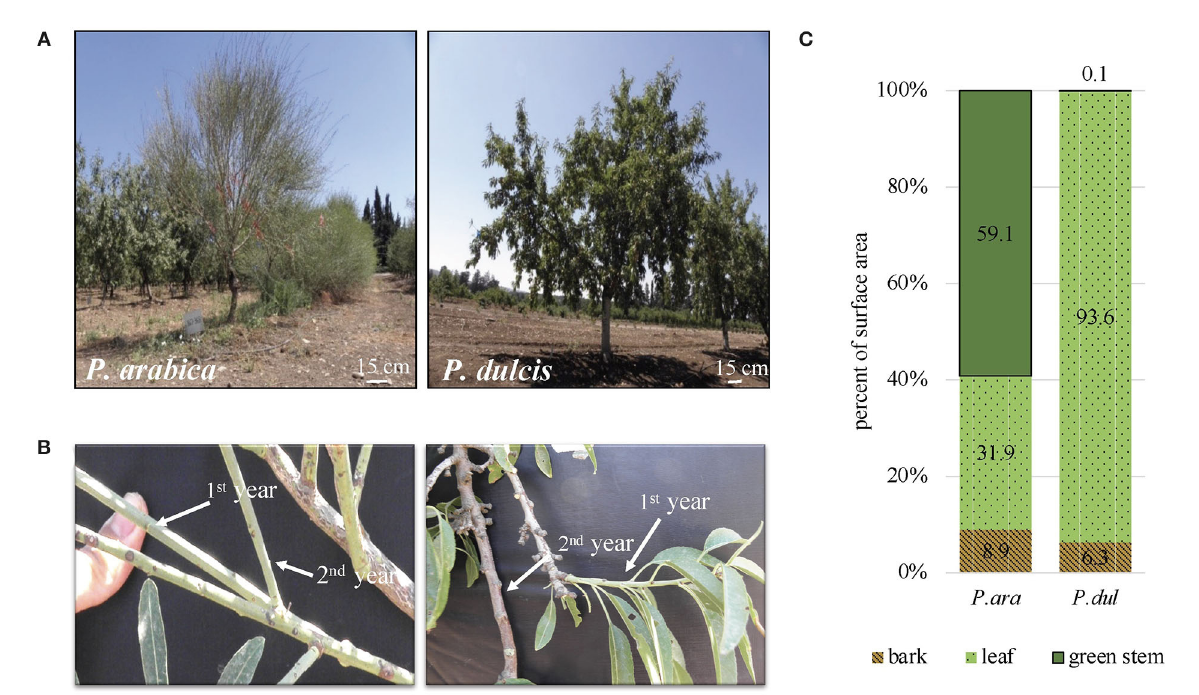
FIGURE1 The wild P. arabica and the commercial cultivar P. dulcis trees show distinctive architecture. Representative pictures of P. arabica ( P. ara ) and P. dulcis ( P. dul ) (A) whole trees and (B) 1 st and 2 nd -year stems (C) Surface area measurements of the tree green stems, barked stems, and leaves in P. arabica and P. dulcis . Results are presented as percent of the total surface area of the aboveground parts of the tree.